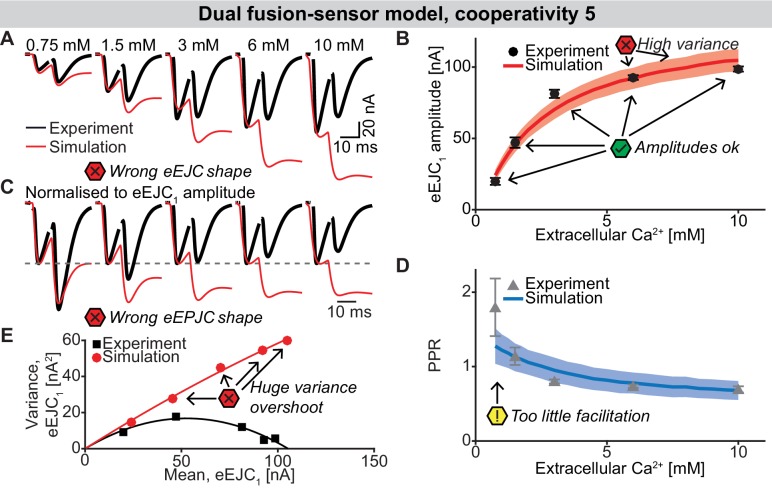
The dual fusion-sensor sensor model with cooperativity 5 (allowing the binding of 5 Ca2+ to the second fusion sensor).(A) Average, experimental eEJC1 traces (black) together with average simulated traces (red). The higher cooperativity increases the PPR compared to cooperativity 2 (Figure 6), but introduces massive asynchronous release resulting in distorted eEJC shapes. (B) eEJC1 amplitudes of experiment (black) and simulation (red). Error bars and colored bands show standard deviation. Like with the three models described in the main text, simulations of this model reproduces eEJC1 amplitudes well, but the variance at the higher extracellular Ca2+ concentrations is too large. (C) Average, normalized eEJC traces of experiment (black) and simulation (red). Like in (A) the wrong shape of the eEJC is evident. (D) PPR values of experiment (gray) and simulation (blue). Error bars and colored bands show standard deviation. Despite the increase in PPR compared to the dual fusion-sensor model with cooperativity 2, the PPR is still too low. (E) Plot of the mean synaptic variance vs. the mean eEJC1 values, both from the experiment (black) and the simulation (red). The curves show the best fitted parabolas with forced intercept at (0,0) (simulation: Var = −0.00089*< eEJC1>2+0.6728 nA*< eEJC1>, corresponding to nsites = 1124 and q = 0.67 nA when assuming a classical binomial model (Clements and Silver, 2000), see Materials and methods). This model leads to an even larger overshoot of the variance than the dual fusion-sensor model with cooperativity 2 (Figure 6). Experimental data (example traces and means) depicted in panels A-E are replotted from Figure 2A–D,F. Parameter values used for simulations can be found in Tables 1–3. Simulation scripts can be found in Source code 1. Results from simulations (means and SDs) can be found in the accompanying source data file (Figure 6—source data 1).